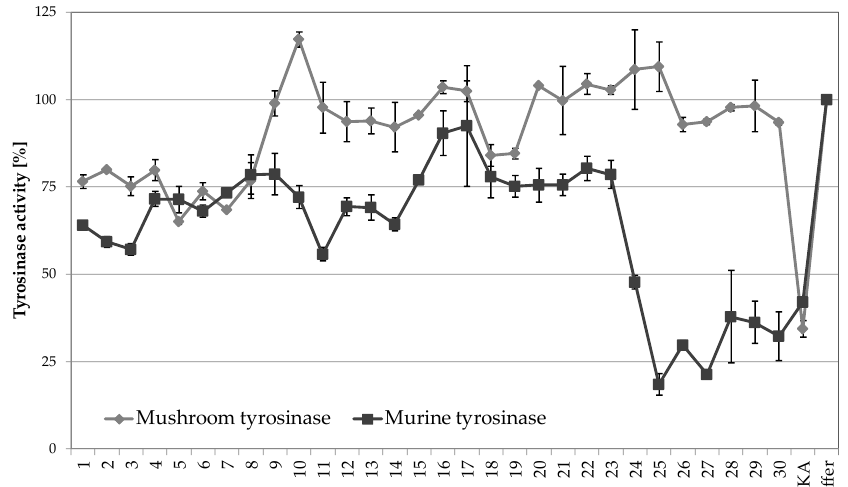
Figure 4. Mushroom and murine tyrosinase inhibitory properties of A. biebersteinii fractions (100 µg/mL) prepared using various extraction protocols; 100 µg/mL kojic acid (KA) was used as a positive control; graph shows mean values ± SD, n = 3.